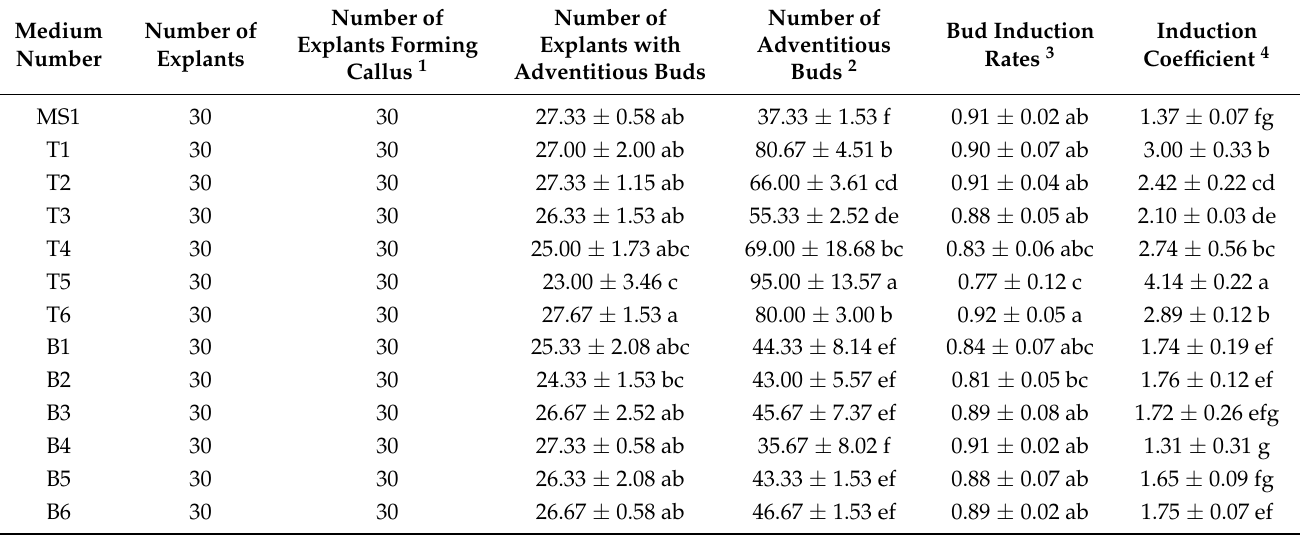
Table 3. The effects of plant growth regulators on adventitious bud regeneration.